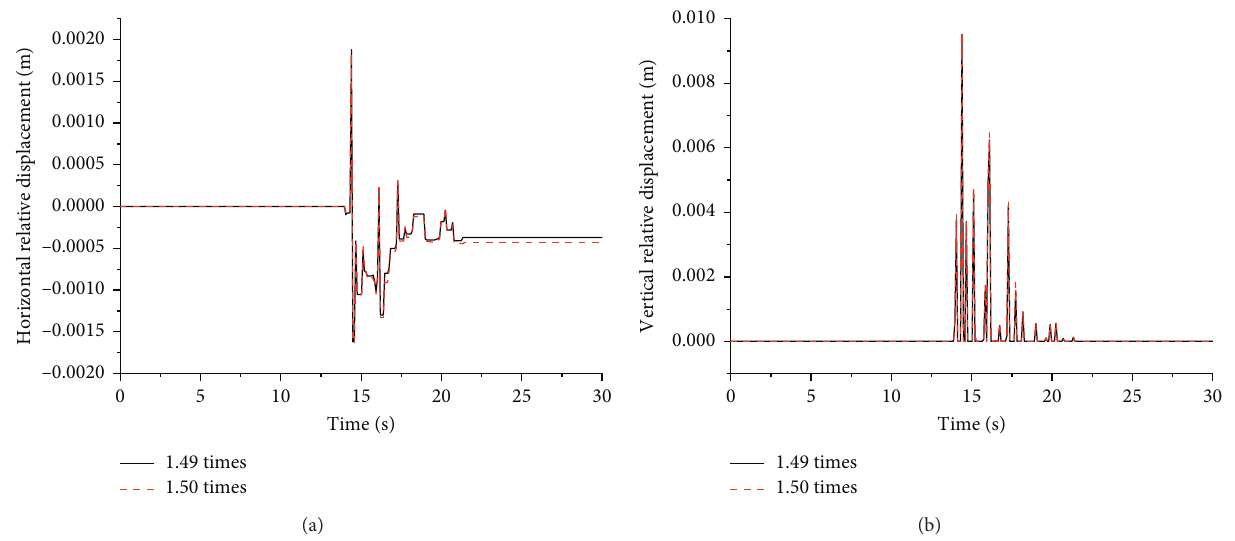
Figure 22: Time histories of displacement difference of joint pairs of 1. (a) Horizontal. (b)